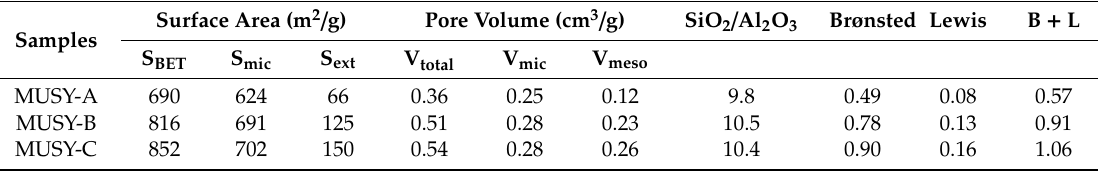
Table 1. Textural parameters and acid properties of the zeolite samples.